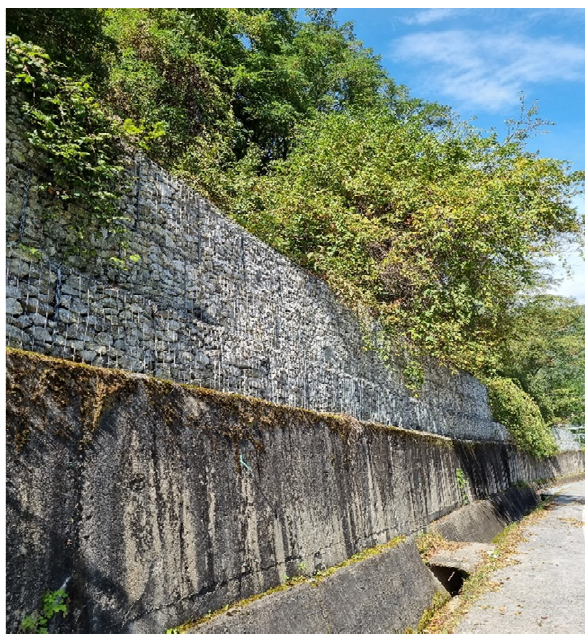
Figure 8. Complex GGSJ (concrete, gabion, artificial soil).